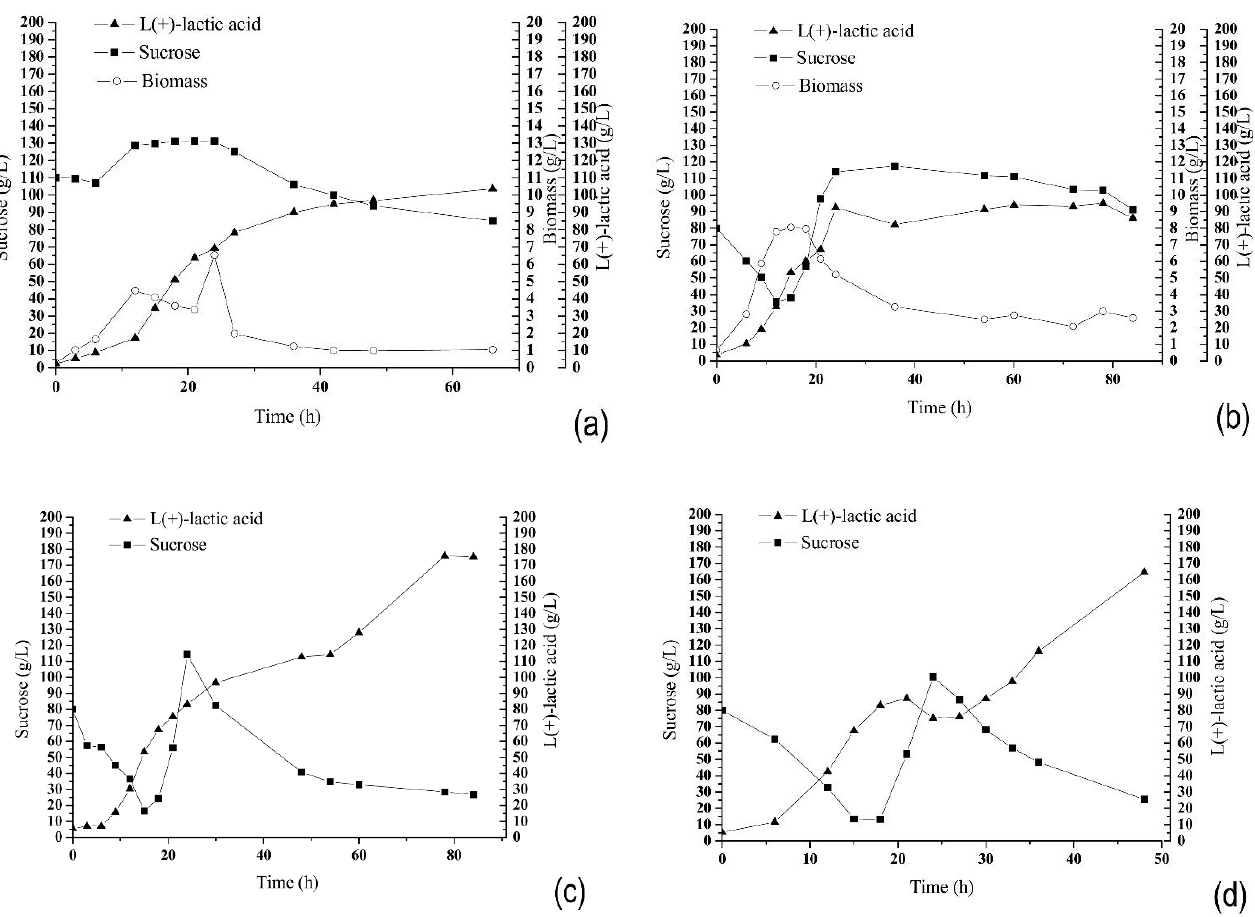
Figure 8. Kinetics of production of L(+)-lactic acid, sucrose consumption and growth of microorganism L. casei Ke 11 in 0.5-L reactor in exponential fed batch fermentation with ( a ) manual regulated feeding ( b ), feeding regulated by software and control of pH with NaOH 10 N, ( c ) feeding regulated by software and control of pH with NaOH 10 N and CaCO 3 and ( d ) with regulated by software and control of pH by CaCO 3 alone.